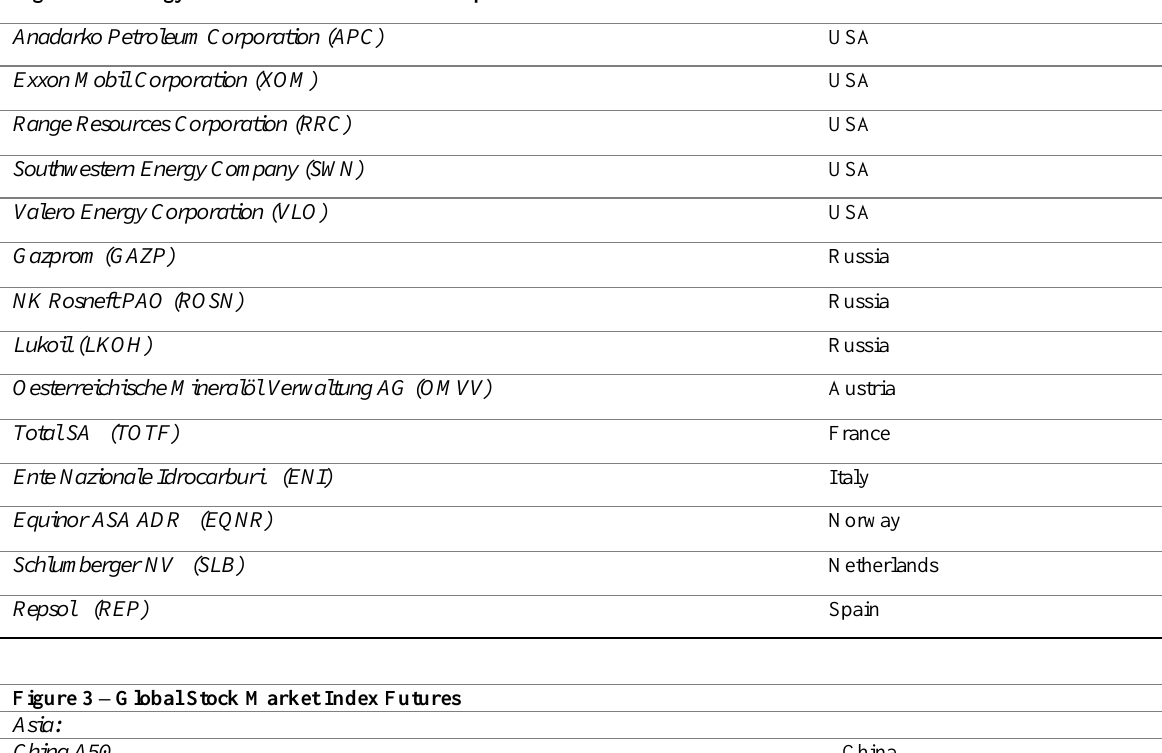
Figure 3 – Global Stock Market Index